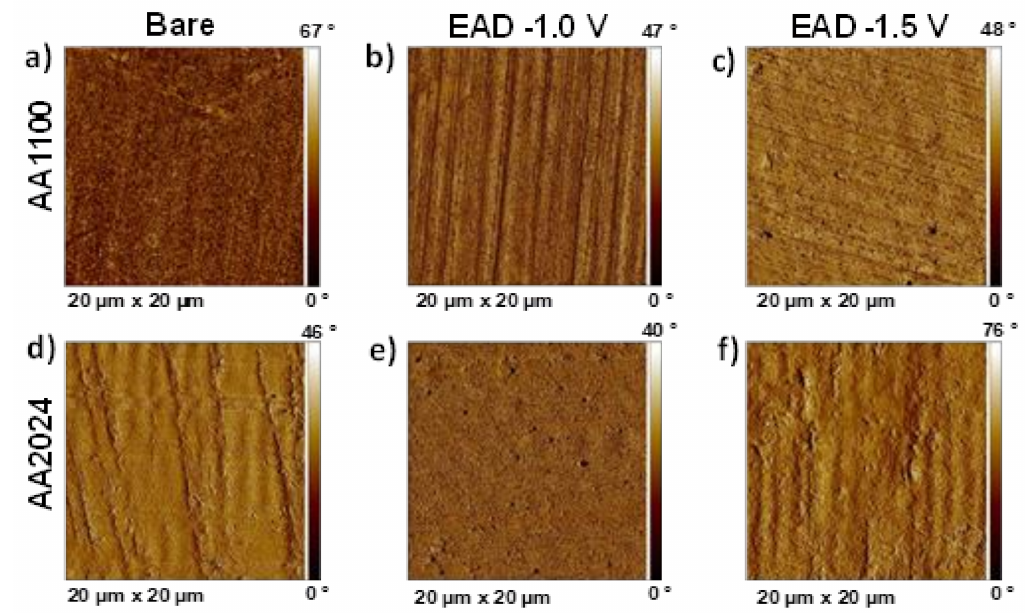
Figure 6. AFM 2D phase images of: ( a ) AA1100 Bare sample, after raw material degreasing; ( b ) Zr-EAD at − 1.0 V/AA1100; ( c ) Zr-EAD at − 1.5 V/AA1100; ( d ) AA2024 bare sample, after raw material degreasing; ( e ) Zr-EAD at − 1.0 V/AA2024; ( f ) Zr-EAD at − 1.5 V/AA2024.